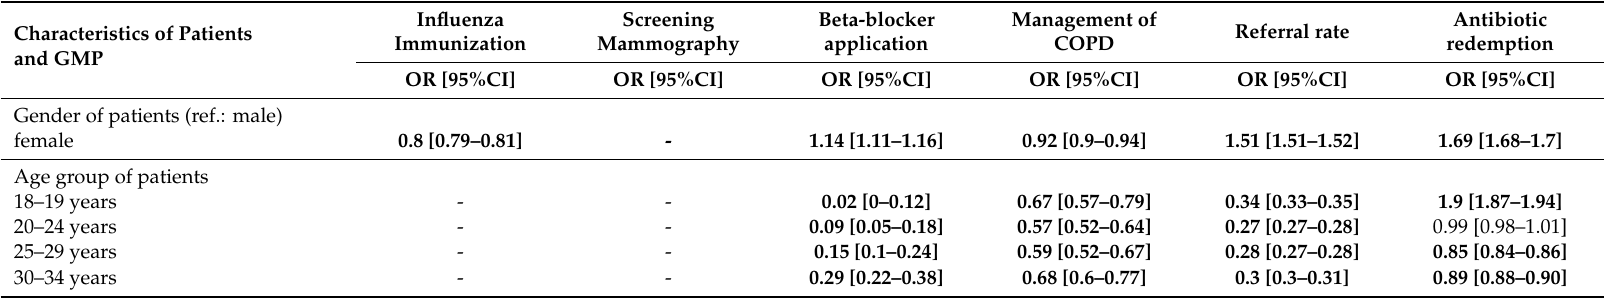
Table 5. Influence of characteristics of patients and general medical practices (GMPs) (Odds Ratio, 95% confidence intervals) on the primary healthcare indicators, according to multilevel logistic regression analysis in Hungary in